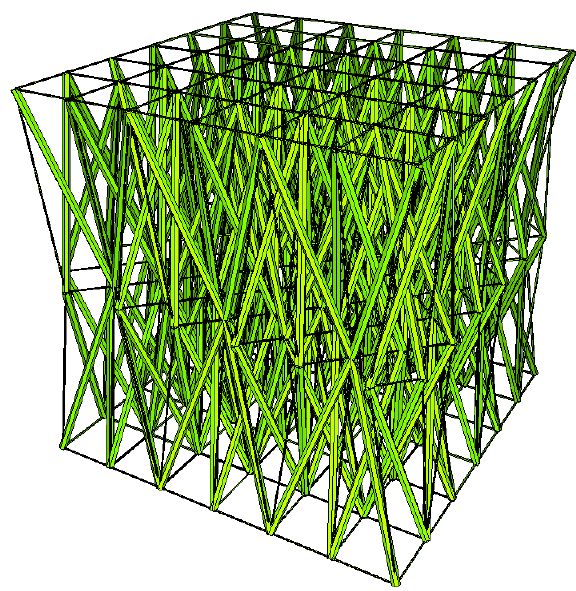
Figure 3. Tensegrity lattice with high modules (H).